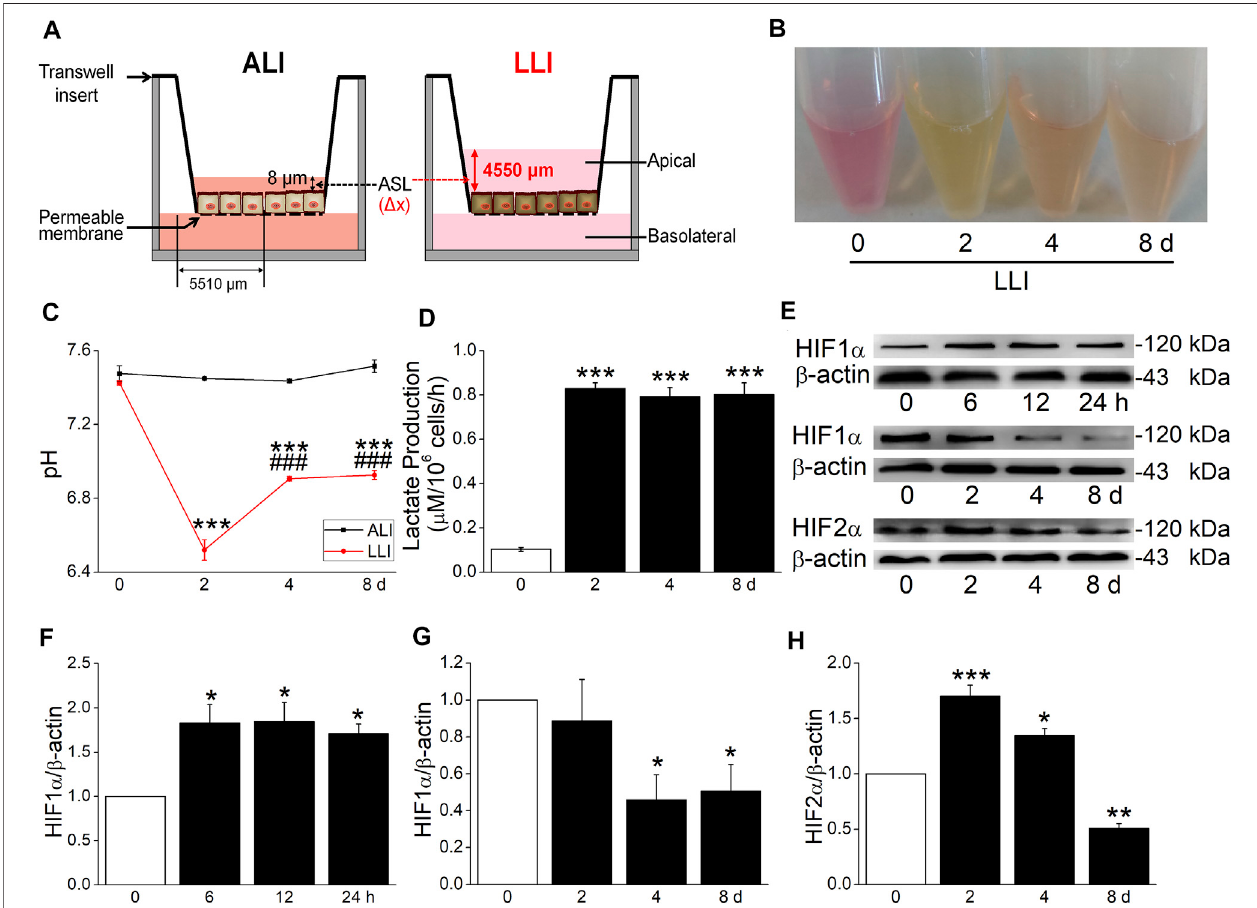
FIGURE1| HypoxiamodelofMTECsestablished. (A) Aschematicdiagramhighlightingthedistanceofoxygendiffusion( Δ x )wasdifferentinALIandLLImode.The thickness of airway surface liquid was about 8 μ m in ALI mode and 4550 μ m in LLI mode. (B – D) Color, pH, and lactate production of MTEC medium after 0, 2, 4, and 8 days ’ LLIculture.*** p < .001,comparedwiththe0 daygroup, n (cid:1) 3 – 6.One-wayANOVAfollowedbyBonferroni ’ stestwasusedtoanalyzethedifferenceofthemeans for signi fi cance. (E) Representativegraphofhypoxia-induciblefactors (HIFs)after different timeintervals inLLI mode. (F – H) Thestatistical dataofHIF1 α and HIF2 α in the mode of LLI culture. * p < .05, ** p < .01, *** p < .001, compared with ALI mode (0 h/d), n (cid:1) 3 – 4. Mann – Whitney U test was used to analyze the difference of the means for signi fi cance in (F) and (G) , One-way ANOVA followed by Bonferroni ’ s test was used to analyze the difference of the means for signi fi cance in (H)